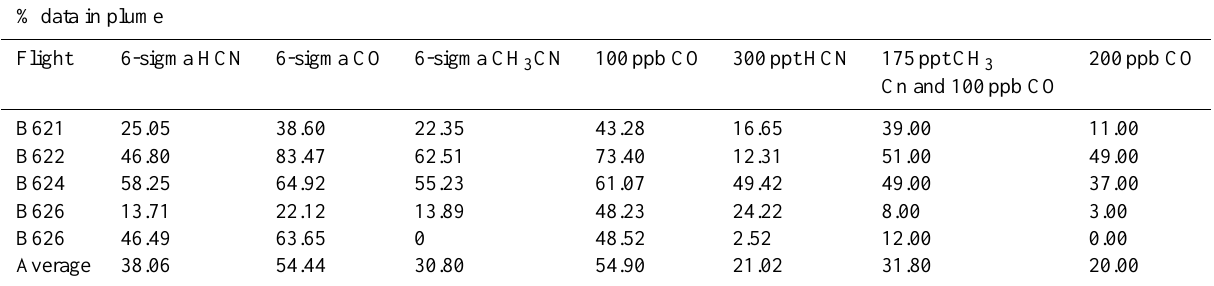
Table 4. Percentage of data determined to be within a plume from the BORTAS flights using varying possible plume identification methods. % data in